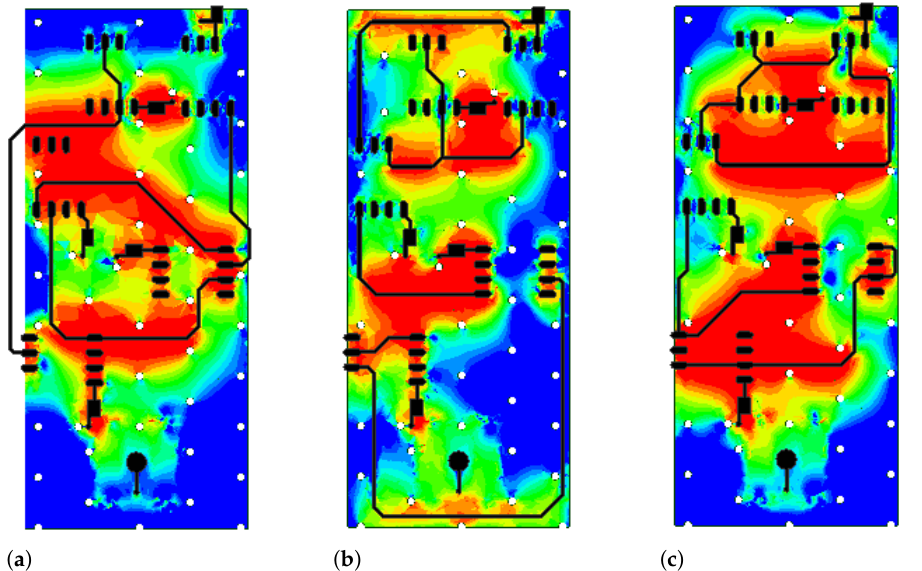
Figure 9. Power plane surface current density for varying trace routing layouts: ( a ) Layout 1, ( b ) Layout 2, and ( c ) Layout 3. Pads and traces are colored black to indicate where openings in the top layer exist. The plots show that surface currents are first excited where openings exist, indicating that electromagnetic energy reaches the power plane through these